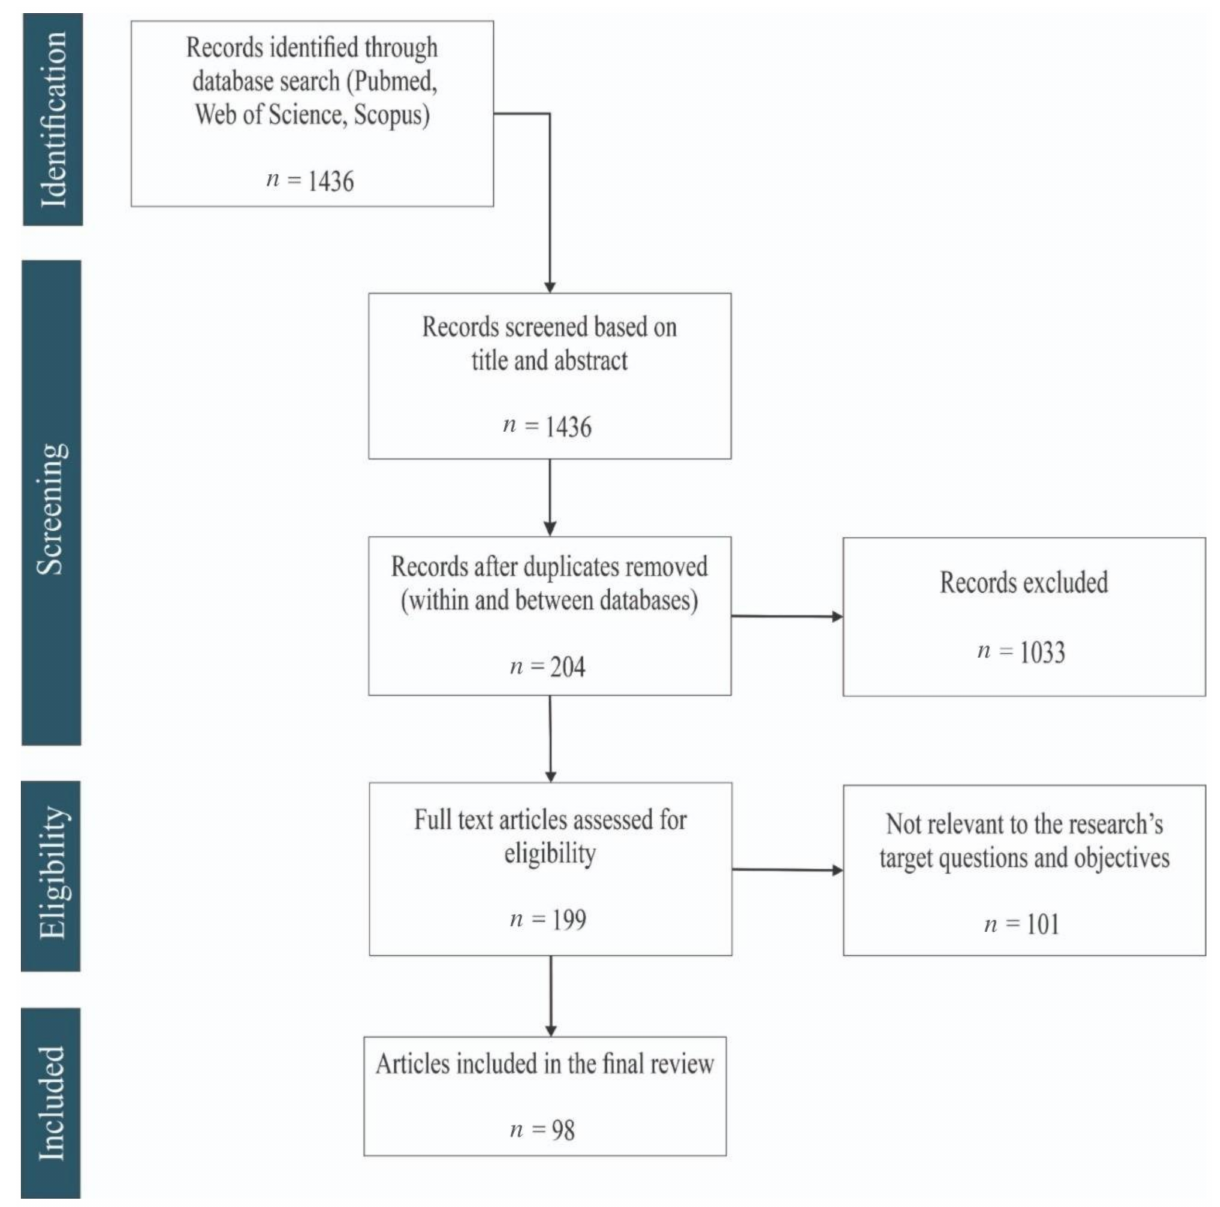
Figure 2. PRISMA chart showing the screening process for the selection of eligible